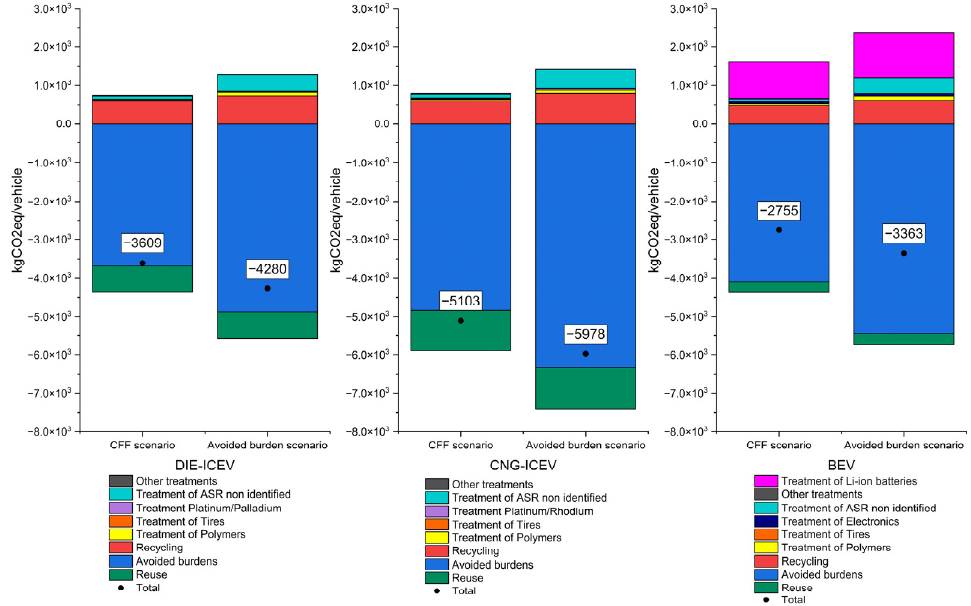
Figure 5. GWP impact of the EoL stage of the three vehicle configurations adopting the CFF and avoided burden scenarios.